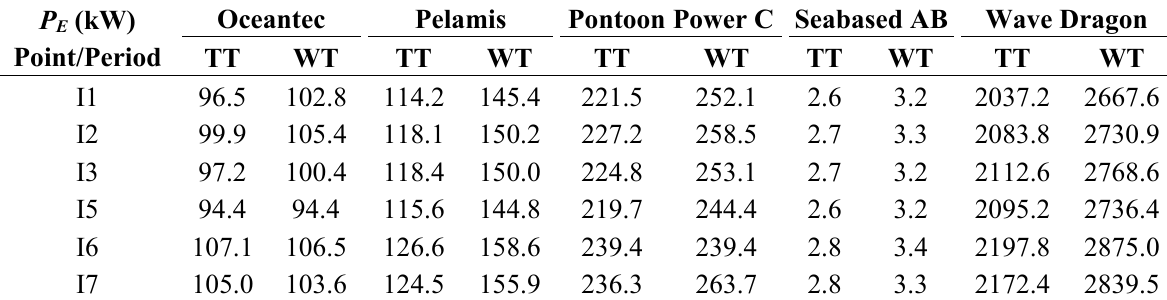
Table 3. Spanish nearshore, average electric power in kW for the six most energetic reference points studied, estimations corresponding to the characteristics of five different WEC